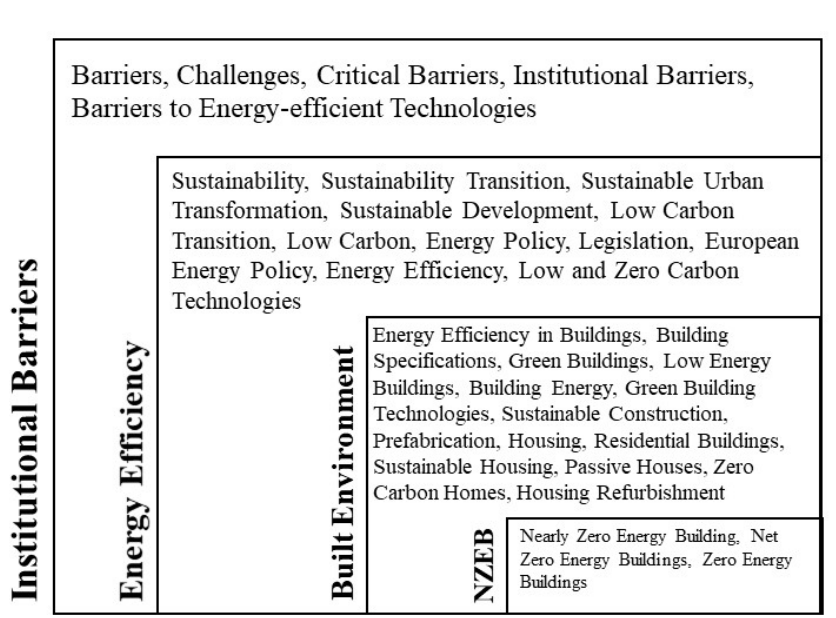
Figure 2. Main research concepts and derived study keywords.